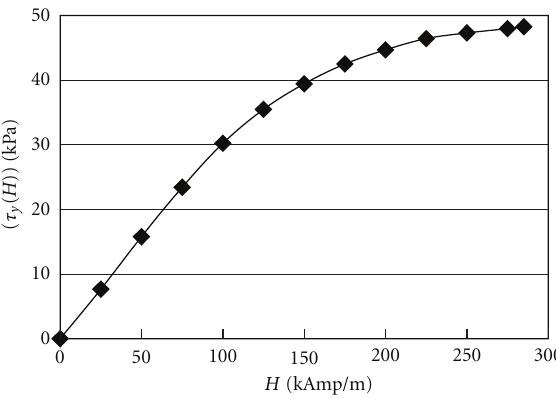
Figure 4: Yield strength versus magnetic field strength.